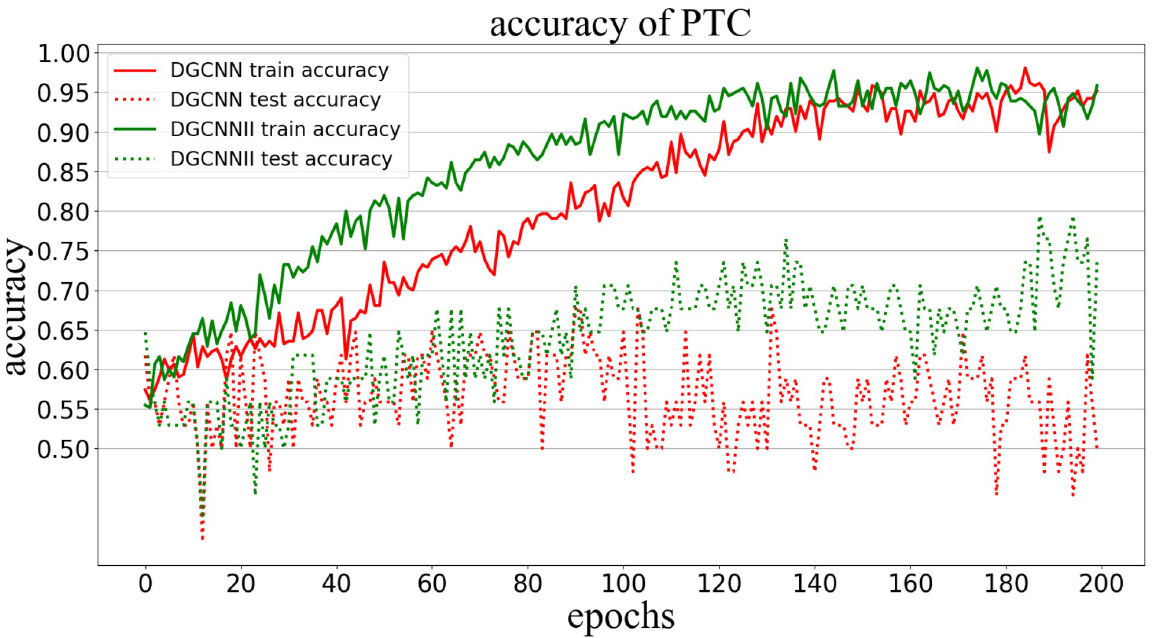
Fig 6. Comparison of graph classification accuracy between DGCNNII and DGCNN on PTC dataset.